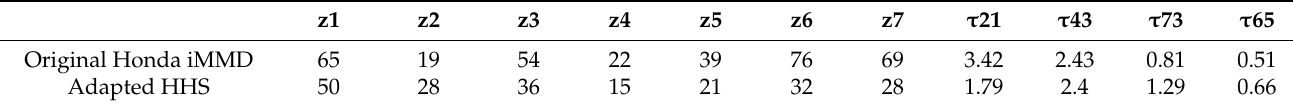
Table 1. Relevant engine working points. Table 2. Number of teeth (z) and transmission ratios ( τ